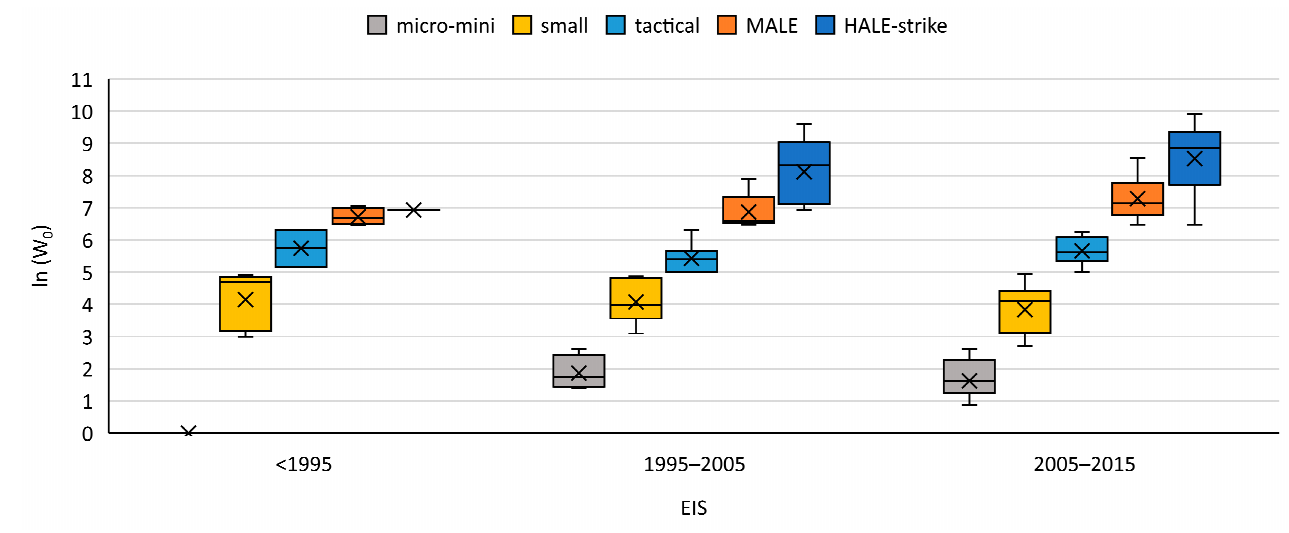
Figure 23. GTOW EIS progression per NATO category.